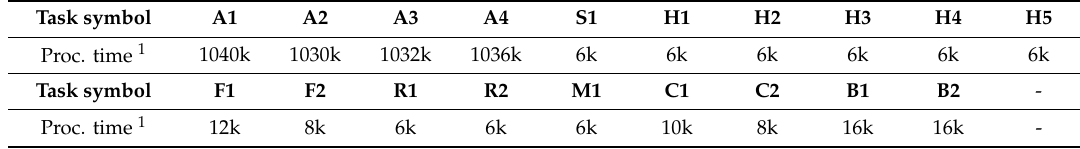
Table 14. Processing time required for performing tasks.